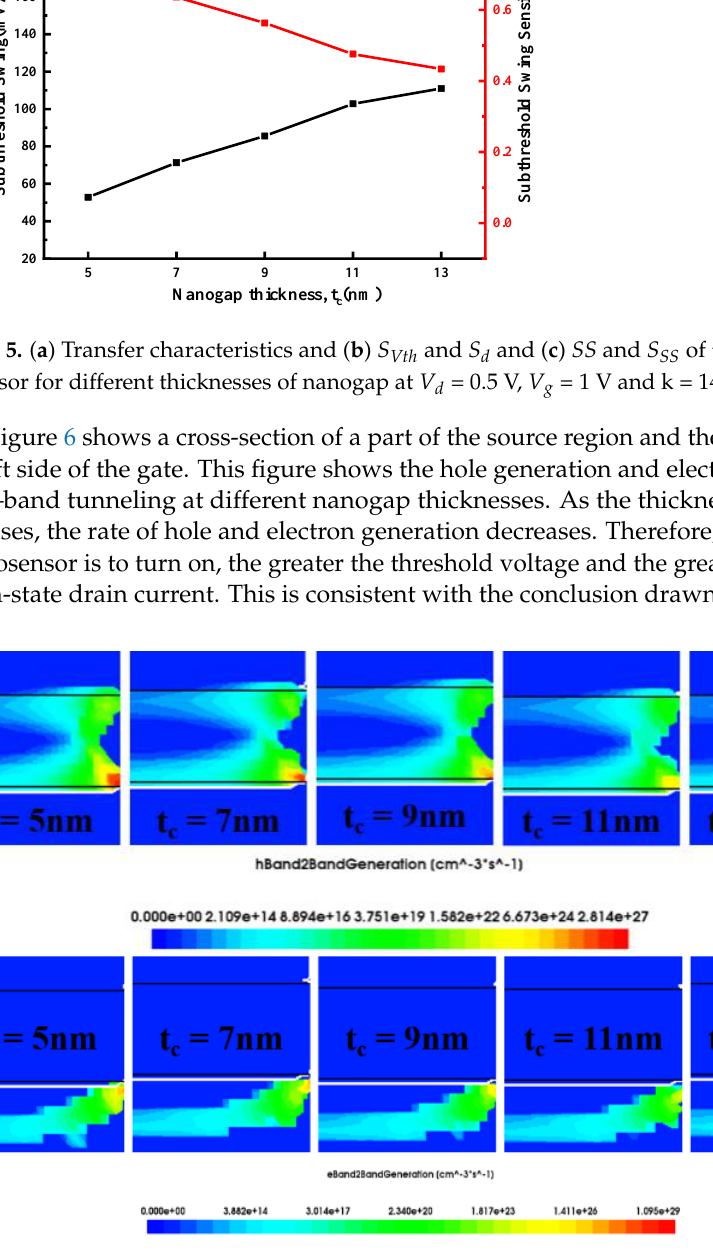
Figure 6. ( a ) The hole generation rate and ( b ) electron generation rate in the source and channel regions on the left side of the DM − SSTGTFET biosensor under different thicknesses of nanogap.